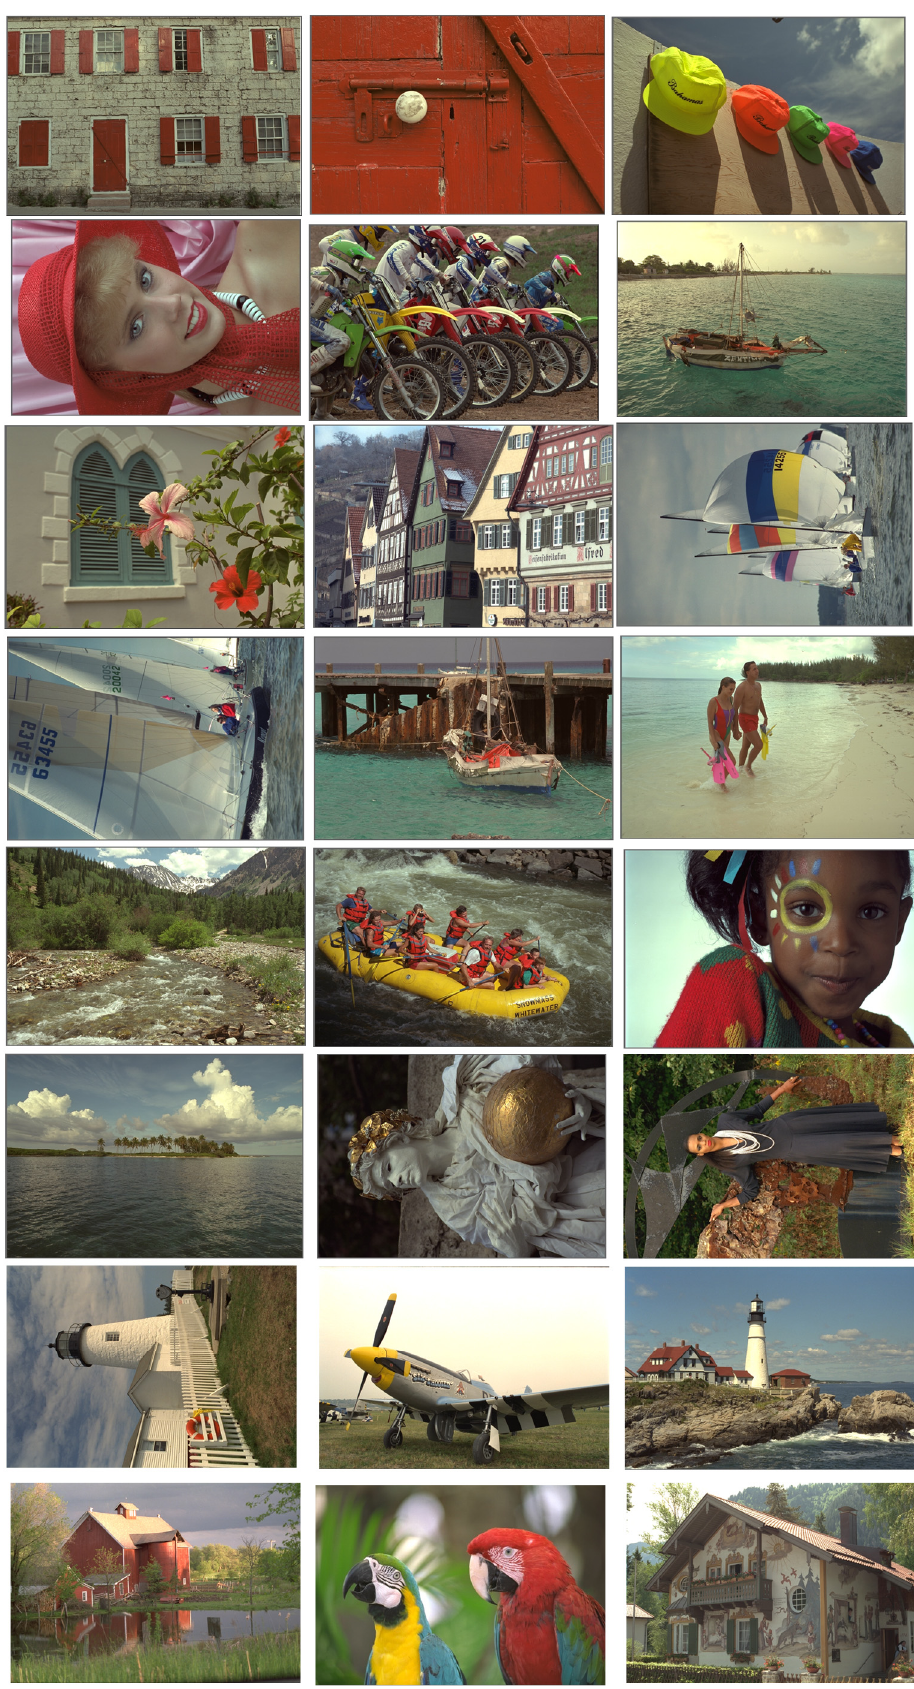
Figure 12. 24 images used for the PSNR comparison in Table 4.